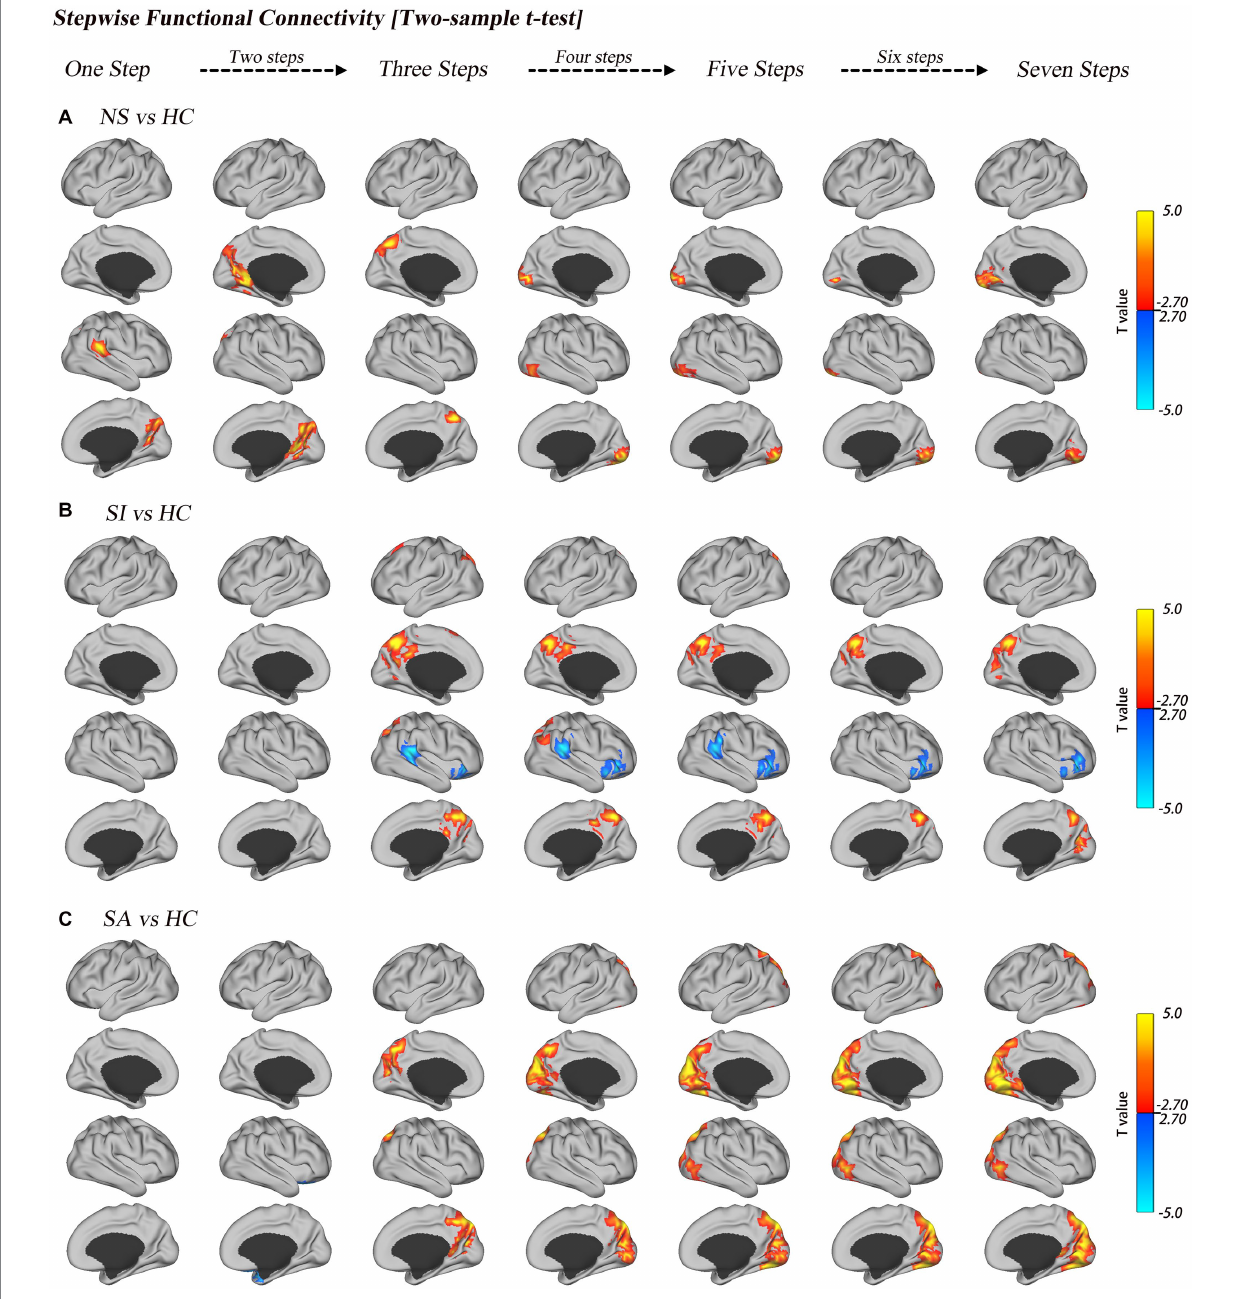
FIGURE 3 Group comparisons of link-step distance between HC and MDD with diverse suicide risks. Surface projections of the two-sample t -test results of the unimodal-to-transmodal link-step distances for NS vs. HC (A) , SI vs. HC (B) , and SA vs. HC (C) . All of the results are displayed after multiple comparison correction (GRF correction, voxel level of p < 0.01, cluster level of p <